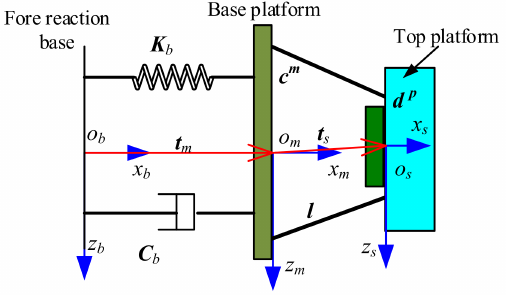
Figure 3. Simplified model of comprehensive test system for train end